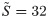
Comparison of approximate solution (for S˜=32, t = 1, Δt = 0.01 and j˜=0.21) and exact solution for Test Problem 3.